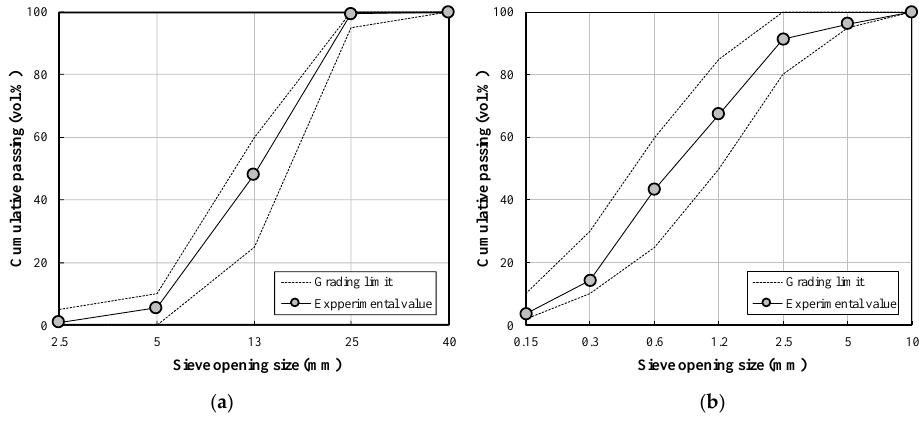
Figure 2. Scanning electron microscopy images of ( a ) OPC and ( b ) GGBS.